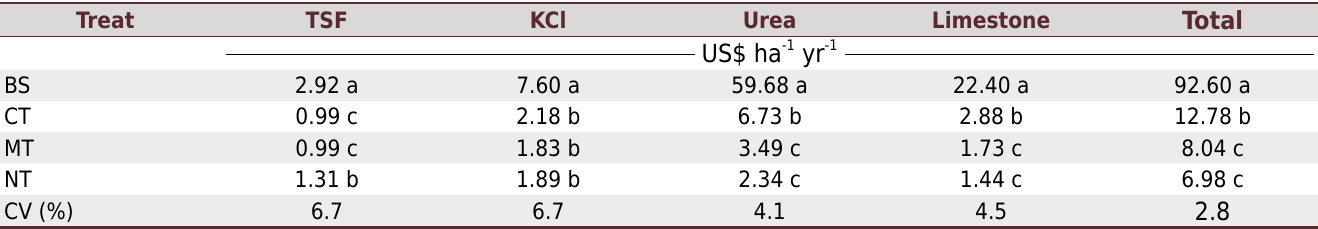
Table 4. Value of triple superphosphate fertilizer (TSF - phosphorus), potassium chloride (KCl - potassium), and urea (nitrogen in the organic matter) and of limestone (Ca + Mg) lost annually in the sediments and water from erosion under natural rainfall, in the different treatments (Treat) in a Humic Cambisol (average of 15 years) Treat